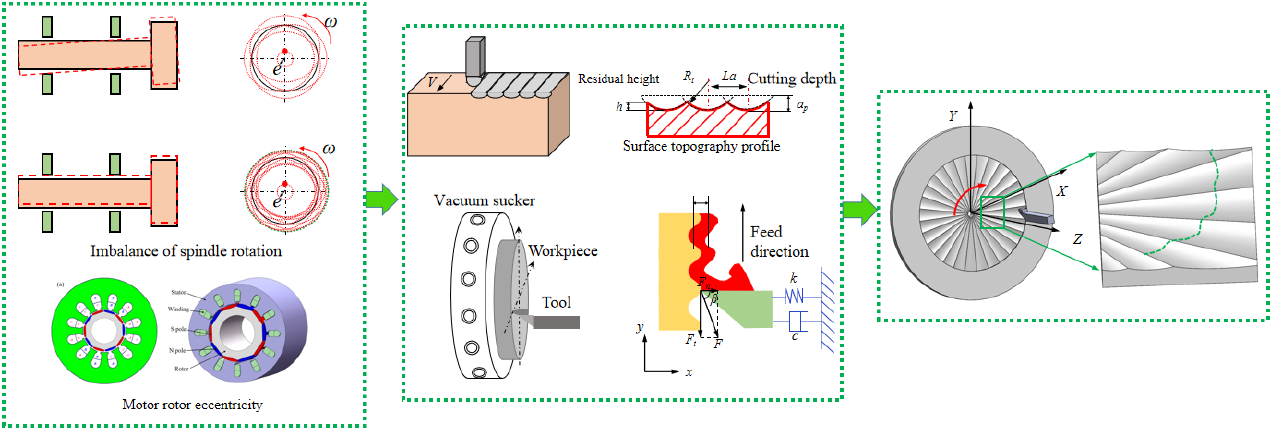
Figure 2. Schematic diagram of the ultra-precision turning.